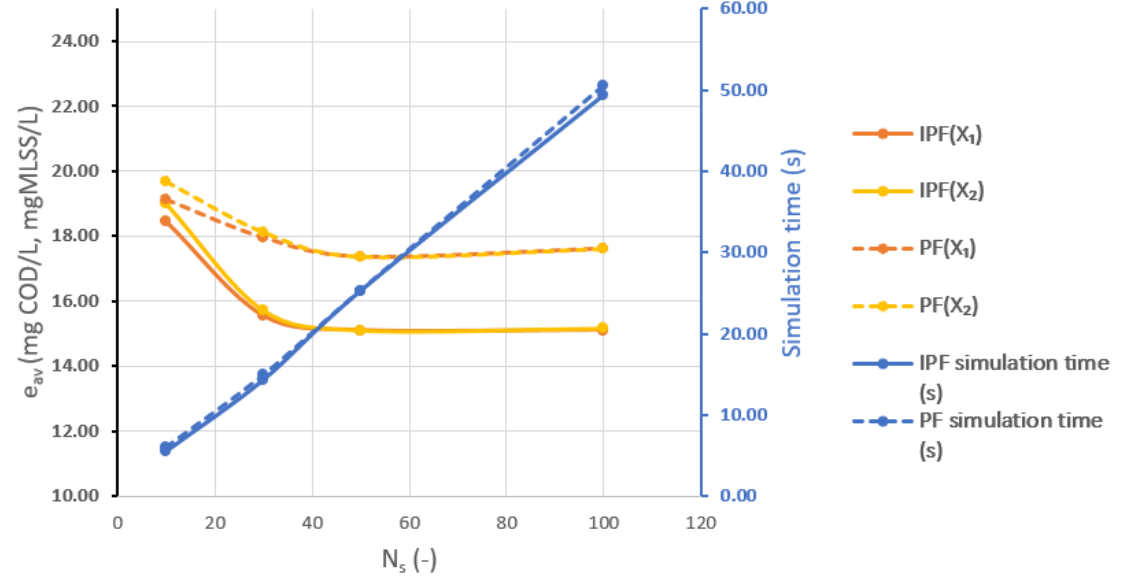
Figure 8. Comparison of PF and IPF: the estimation errors ( e av ) of the concentrations of microorgan- isms and the simulation time regarding the different numbers of particles. The curves belonging to PF are represented by dashed lines and those belonging to IPF by continuous lines. The orange and yellow colors refer to the X 1 and X 2 state variables, respectively. The other parameters are the same as before ( N S = 10, 30, 50, 100; T = 4000; N r =